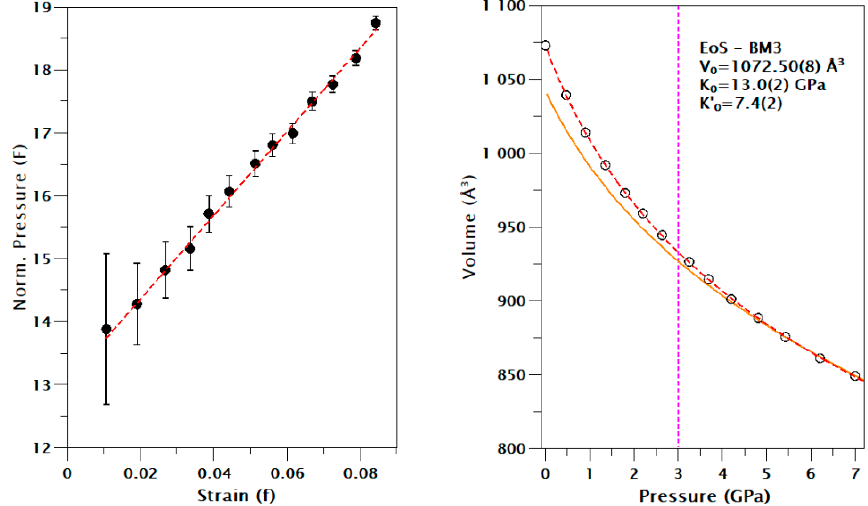
Figure 6. f-F plots and EoS BM3 fit for volume variation for [(CuBr) 2 (Quin)] ( upper ) and [(CuI) 2 (Quin)] ( lower ). Dashed red curves represent the EoS fitting results. Orange curves are the DFT simulations using the PBE + D3 model.